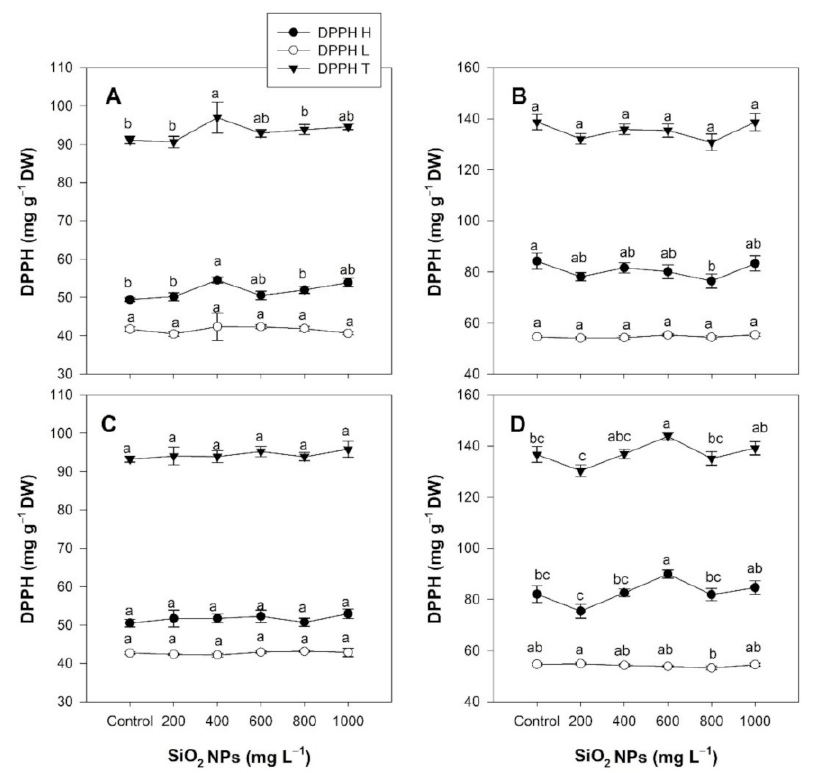
Figure 6. Effect of the application of SiO 2 NPs via the soil method ( A , C ) and the foliar method ( B , D ) on the antioxidant capacity in the leaves ( A , B ) and flowers ( C , D ) of Lilium plants. DPPH H: antioxidant capacity of the hydrophilic compounds. DPPH L: antioxidant capacity of the lipophilic compounds. DPPH T: total antioxidant capacity. Different letters indicate significant differences according to Fisher’s least significant difference test ( p ≤